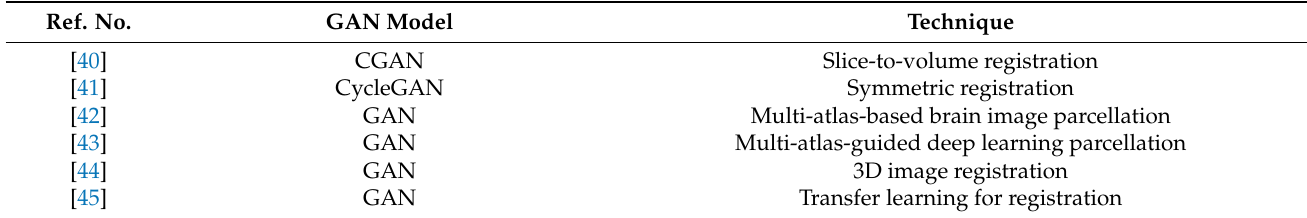
Table 6. Summary of GAN-synthesized images used for registration. Ref. No. GAN Model